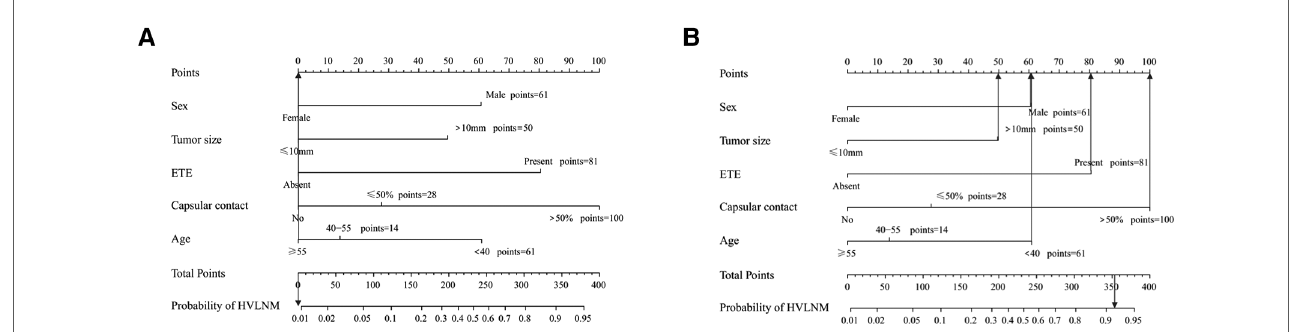
FIGURE 3 The use of the developed nomogram. ( A ) A 75-year-old lady diagnosed as non-HVLNM with a papillary thyroid microcarcinoma, extrathyroidal extension ( − ), capsular contact ( − ). The total score of this patient is 0 and the risk rate of HVLNM was <0.01. ( B ) A 37-year-old man diagnosed as HVLNM with a papillary thyroid macrocarcinoma, extrathyroidal extension (+), capsular contact (>50%). The total score of this patient is 353 and the risk rate of HVLNM was